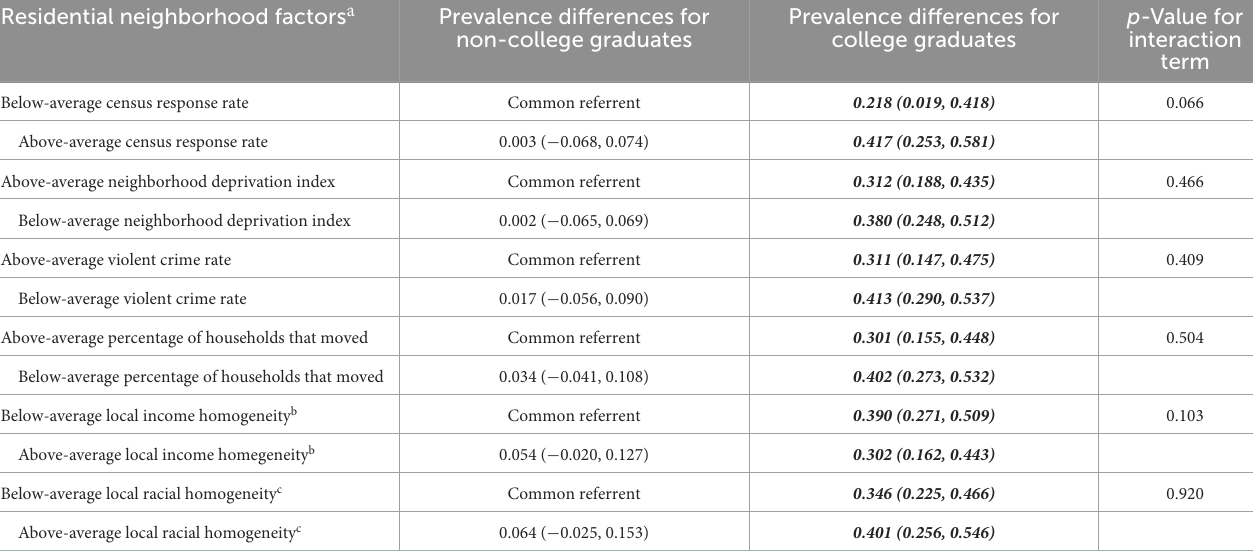
TABLE 2 Joint effects of maternal education and residential neighborhood factors on prevalence of a Lactobacillus (non- iners )—dominant vaginal